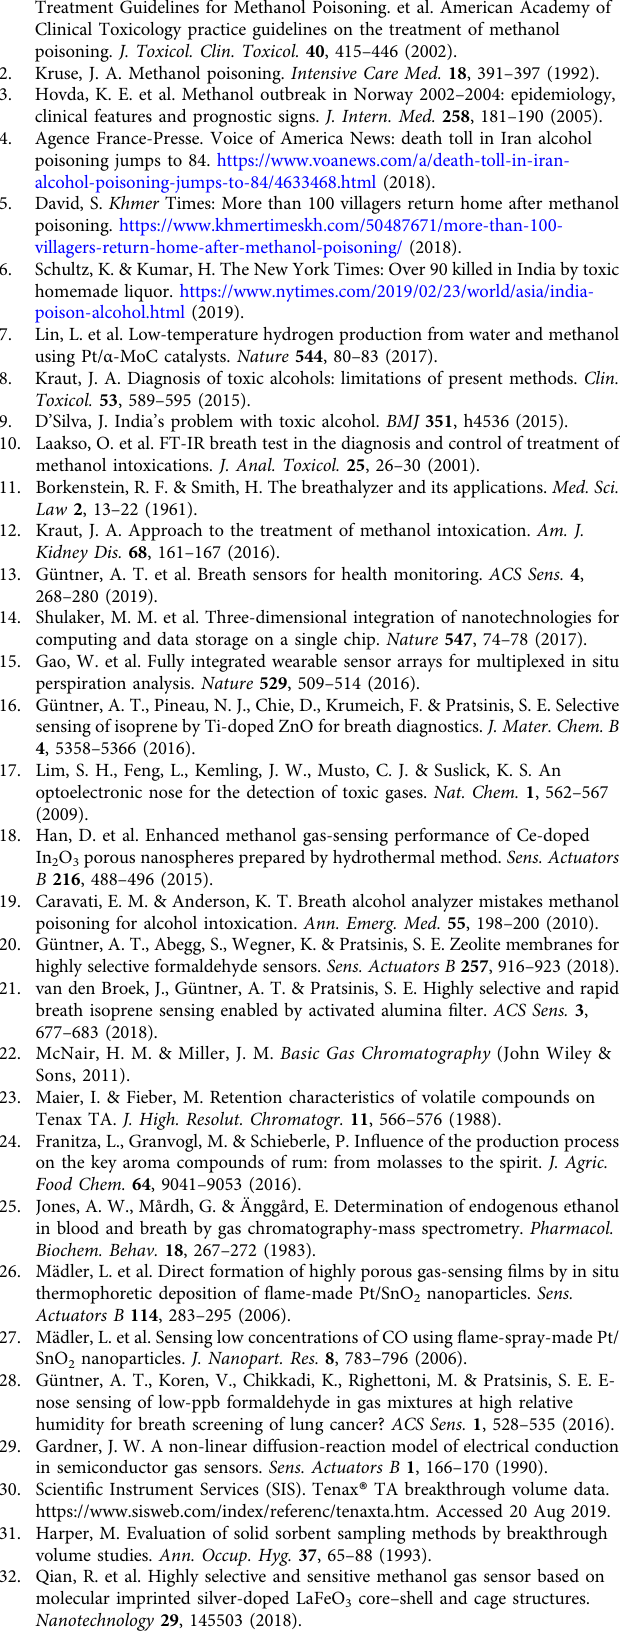
Higher ethanol concentrations (250 – 64,000 ppm) were generated similarly by bubbling air through pure ethanol (absolute, >99.8%, Fisher Chemical) and dilution with synthetic air. Generated concentrations were calculated from the weight loss of the bubbler after bubbling with air for 0, 2, 4, 6, and 8h, while room temperature was kept constant at 22°C.